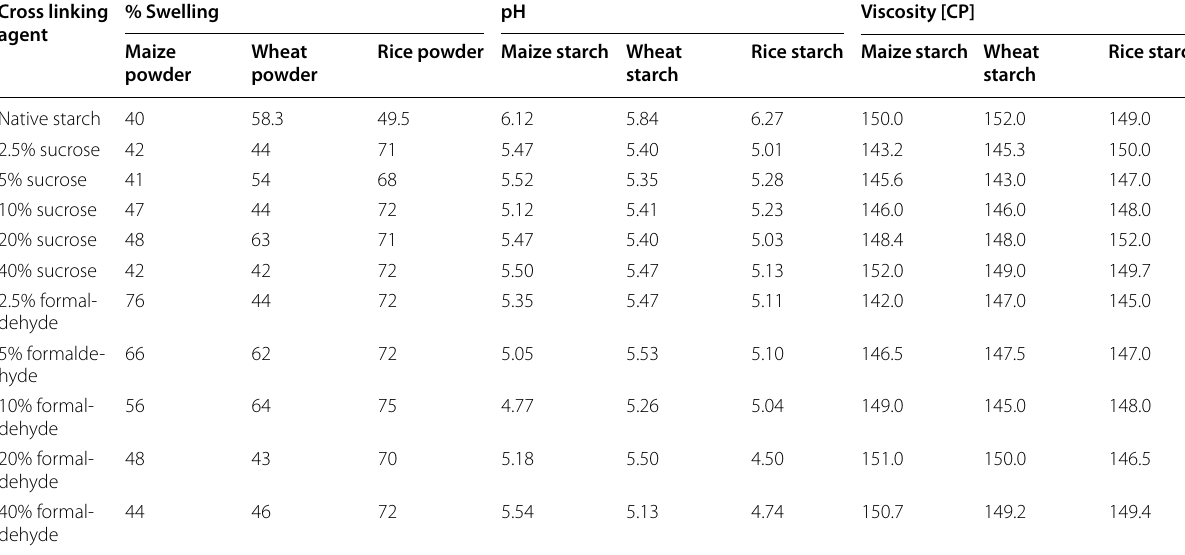
Table 3 Further physicochemical profiles of the cross-linked maize, wheat and rice Cross linking